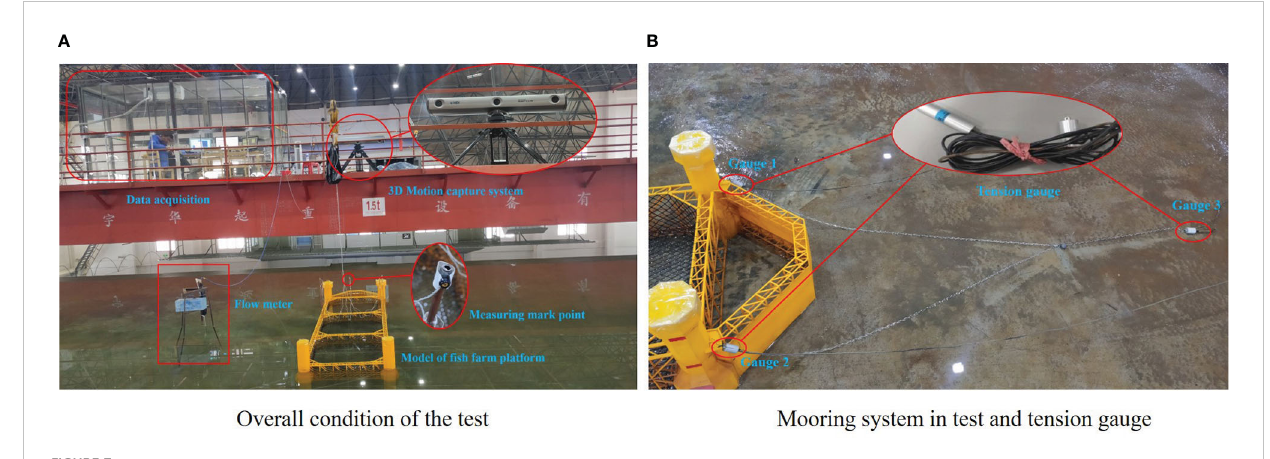
FIGURE 7 Physical modeling test site condition.